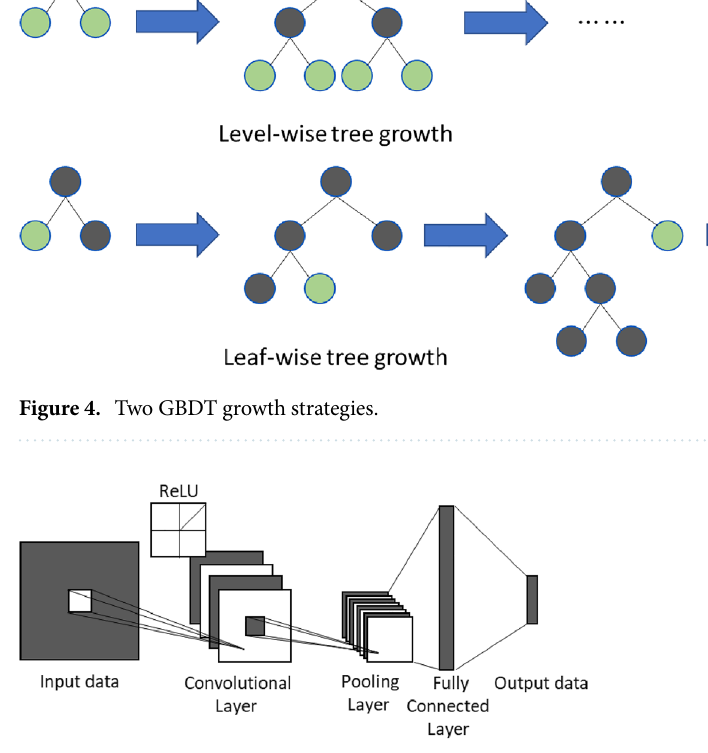
Figure 5. Schematic diagram of a convolutional neural